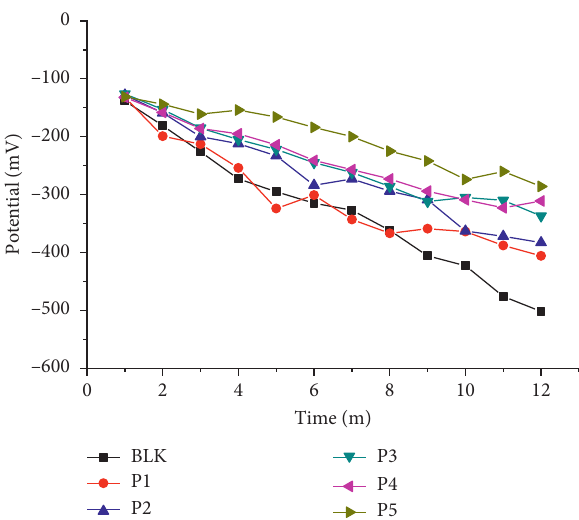
Figure 2: Corrosion inhibitor of Na